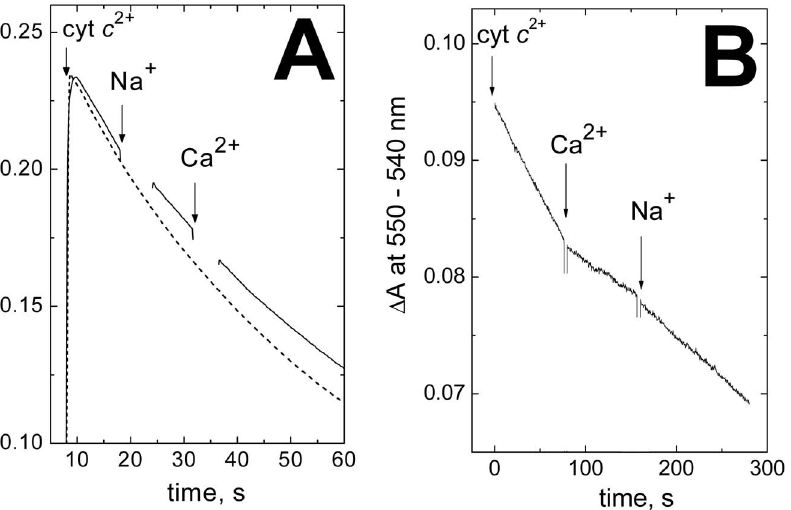
Figure 5. Na + ions counteract the Ca 2 + -induced inhibition of cytochrome c oxidase activity of bovine COX. ( A ) Bovine COX (30 nM) in the basic medium with 0.4 M choline chloride and 15 m M oxidized cytochrome c . The reaction is initiated by addition of 15 m M ferrocytochrome c and oxidation of c 2 + is followed in a dual-wavelength mode at 550 nm vs the 540 nm reference wavelength. Dashed line, control recording (no additions). Solid line, 50 mM NaCl and 200 m M CaCl 2 (100 m M excess over EGTA) are added where indicated. ( B ) Bovine COX (1.3 nM) in the basic medium with 0.4 M choline chloride and with no oxidized cytochrome c . Reaction is initiated by addition of 6 m M ferrocytochrome c . Other additions, as in ( A ).